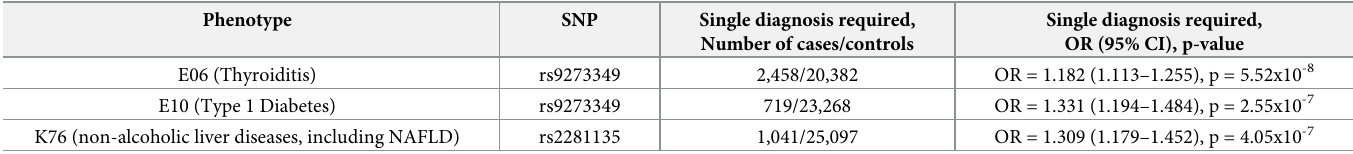
Table 6. Results of the PheWAS using the PheWAS codes and passing the PheWAS significance threshold. Phenotype SNP Single diagnosis required,